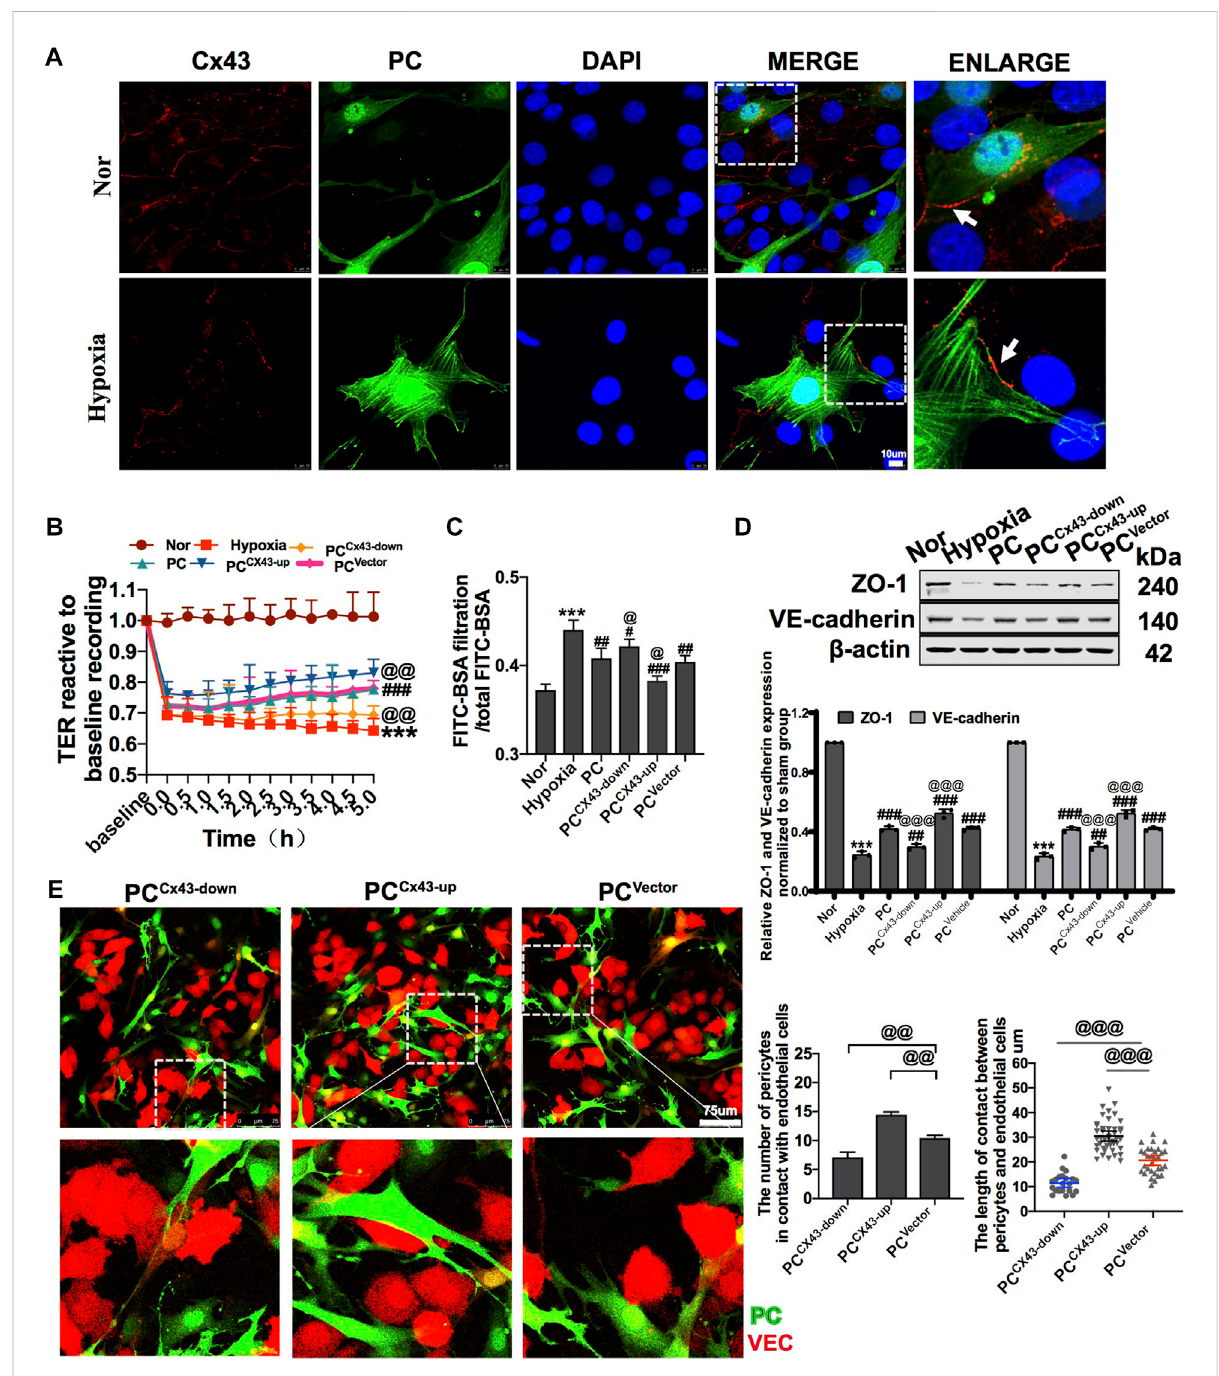
FIGURE 4 Effect of regulating Cx43 expression in PCs on the action of PCs and VECs and VEC barrier function after hypoxia. (A) Expression of Cx43betweenPCsandVECsafterhypoxiadeterminedbyimmuno fl uorescence( n =3). (B) EffectofCx43up-anddownregulationinPCsontheTER of VECs after hypoxia ( n = 3). (C) Effect of Cx43 up- and downregulation in PCs on the in fi ltration rate of FITC-BSA of VECs after hypoxia ( n = 3). (D) Changes of expression of ZO-1 and VE-cadherin in VECs after treatment determined by WB ( n = 3). (E) Direct contact between PCs and VECs observed using a fl uorescence microscope ( n = 3). *** p < 0.001 compared with the Nor group (one-way ANOVA). # p < 0.01, ## p < 0.01, and ### p < 0.001 compared with the hypoxia group (one-way ANOVA). @ p < 0.01, @@ p < 0.01, and @@@ p < 0.001 compared with the PC Vector group (one-way ANOVA). PC Cx43-up : upregulated Cx43 expression in PCs; PC Cx43-down : downregulated Cx43 expression in PCs; PC Vector : transfected with adenovirus vectors in